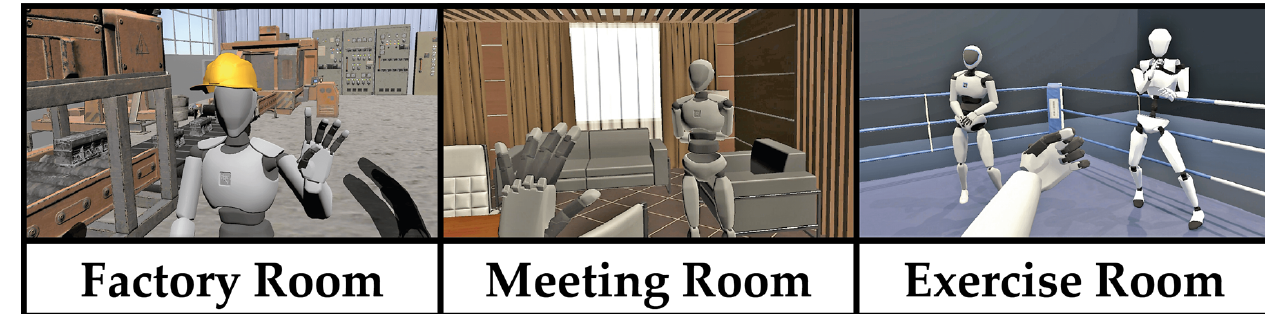
Figure 11. Multi-remote collaboration.